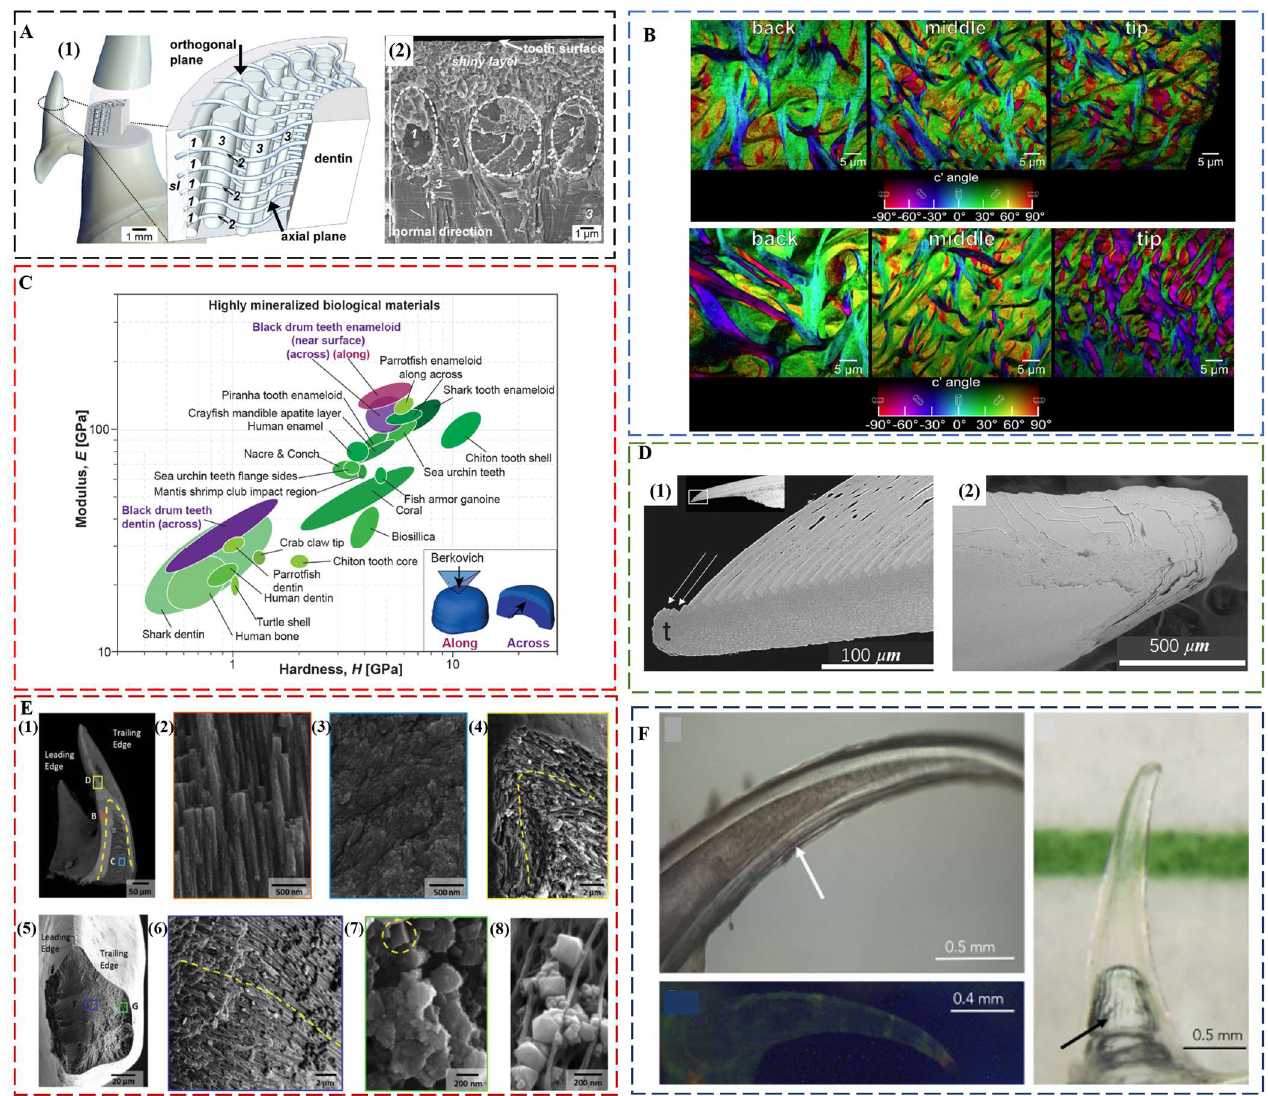
Figure 3. ( A ) Enameloid microstructure of teeth of I. oxyrinchus . (1) Schematic model depicting the locations of the analyzed tooth regions and the spatial arrangement of the fluoroapatite crystallite bundles in the enameloid. The shapes and trajectories of the bundles are simplified, and their sizes are not in scale to each other. (2) Scanning electron micrograph showing the real arrangement of differently oriented crystallite bundles and the ultrastructure of the shiny layer on a fracture plane corresponding to the axial plane of the sketch in (1). sl—shiny layer; 1—circumferential bundles; 2—radial bundles; and 3—axial bundles. Reproduced with permission from J. Enax et al. [78], Elsevier. ( B ) Polarization-dependent imaging contrast maps showing the size and orientation of fibers at the back, the middle, and the tip of the enameloid layer of the biting tooth of parrotfish. Reproduced with permission from M.A. Marcus et al. [81], American Chemical Society. ( C ) Ashby plot of modulus vs. hardness, including the properties of the black drum fish tooth enameloid and dentin measured along and across the biting direction. Reproduced with permission from Z.F. Deng et al. [76], Elsevier. ( D ) The pre-determined breaking positions in self-sharpening sea urchin teeth. (1) The convex side of the tooth tip of sea urchin, which is at the top in this longitudinal section, sheds one primary plate at a time. (2) The tip, which is seen here from the convex side, is clearly not continu- ously breaking but discretely shedding plates one at a time. Reproduced with permission from C.E. Killian et al. [84], Wiley. ( E ) Core–shell architecture and local microstructural features of chiton teeth. (1) Backscattered electrons (BSE) microscopy overview of a longitudinal fracture, highlighting a heavily mineralized outer shell and organic rich core. (2) Aligned and staggered nanorods in the leading edge of the shell. (3) Amorphous core region. (4) Apex of longitudinal fracture, revealing nanorod orientation and continuity around the shell of the tooth. (5) Latitudinal fracture near the